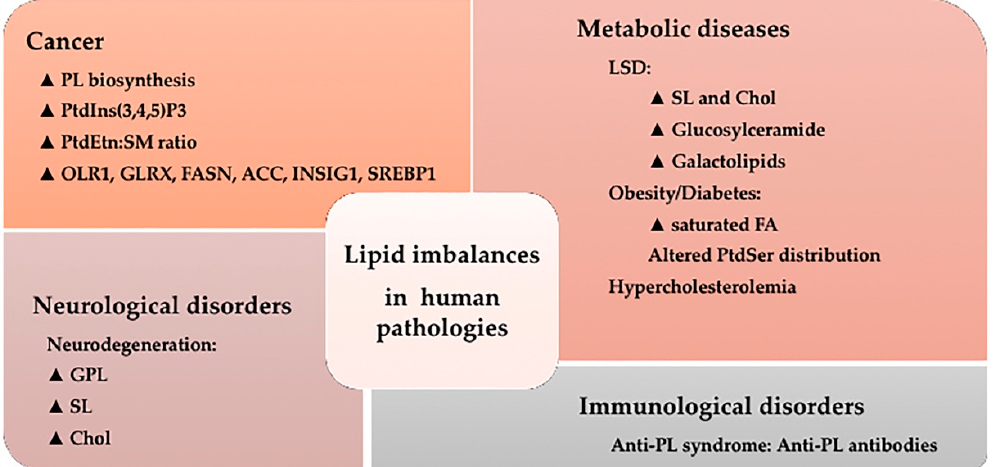
Figure 4. Lipid imbalances and human pathologies. Snapshot of the alterations in the lipidome which have been described in a variety of pathological situations. ▲ , increased levels or pathway activity;